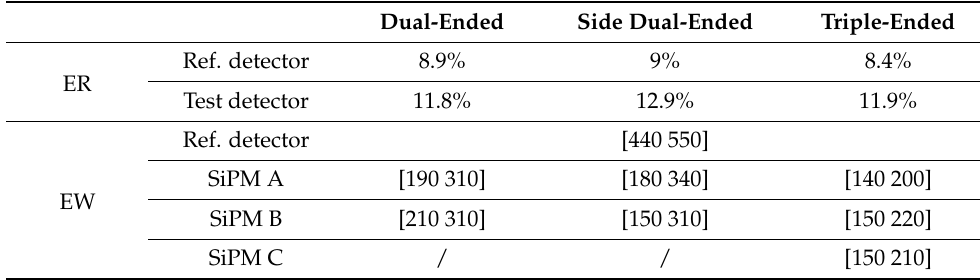
Table 2. Energy resolutions and energy